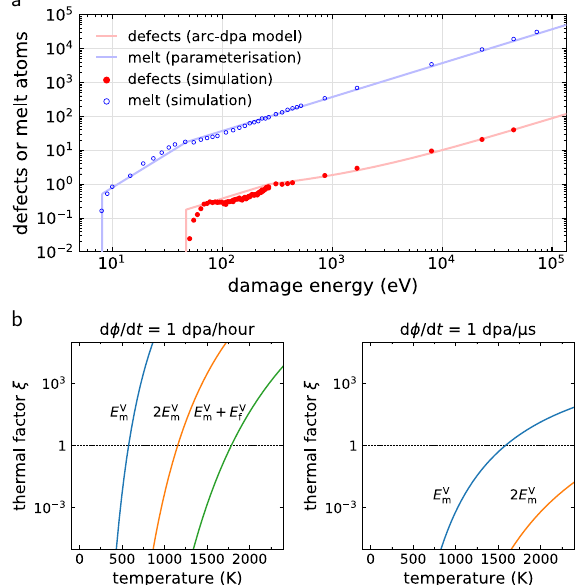
Figure 2. Estimating the phase space of the athermal regime. ( a ) Simulation and model for the mean number of defects and molten atoms generated by a cascade with given damage energy in tungsten. The standard error is smaller than the marker size. ( b ) Thermal factor (5) for dose rates d φ/ d t representative of experiment and of cascade simulations. With decreasing temperature, thermally-activated processes with higher energy barriers become frozen out ( ξ ≪ 1 ), as any given region in the crystal becomes more likely to be impacted and molten by a cascade before a thermally activated transformation occurs. For pure tungsten, E melt = 2.70 eV and the transformation barriers are: for vacancy migration E V m = 1.72 eV, for self-climb 20 2 E V m = 3.44 eV, and for vacancy-mediated climb 21 E V m + E V f = 5.32